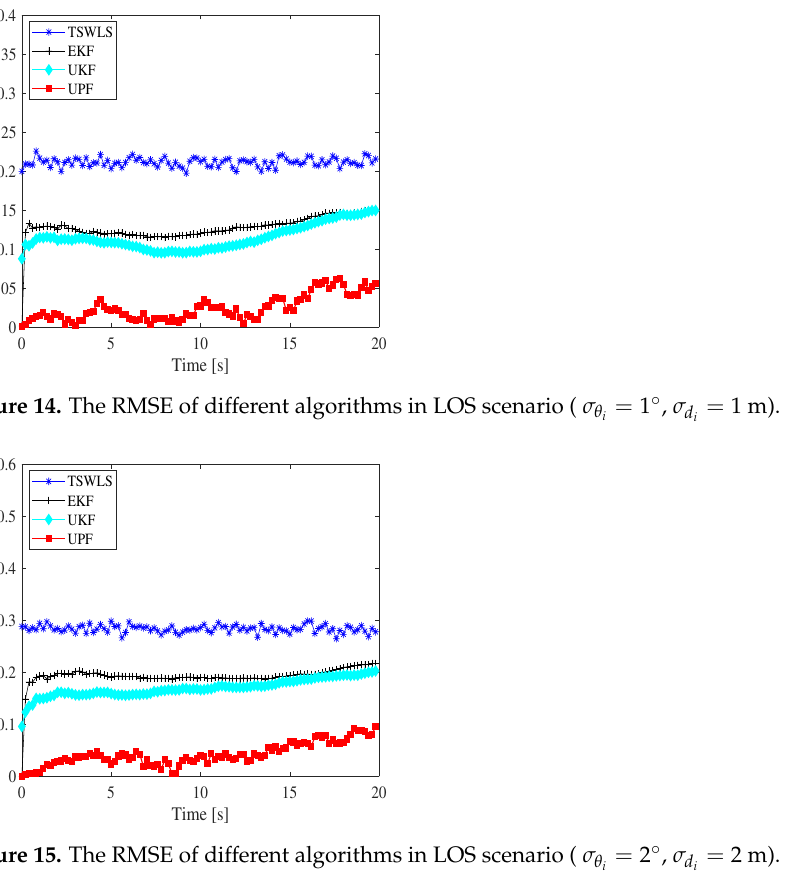
and TSWLS algorithms.